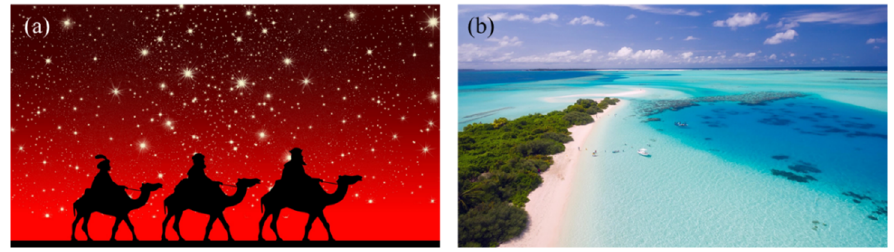
Figure 15. Two tested images for micro-LED TVs: ( a ) Christmas, and ( b ) Maldives beach.